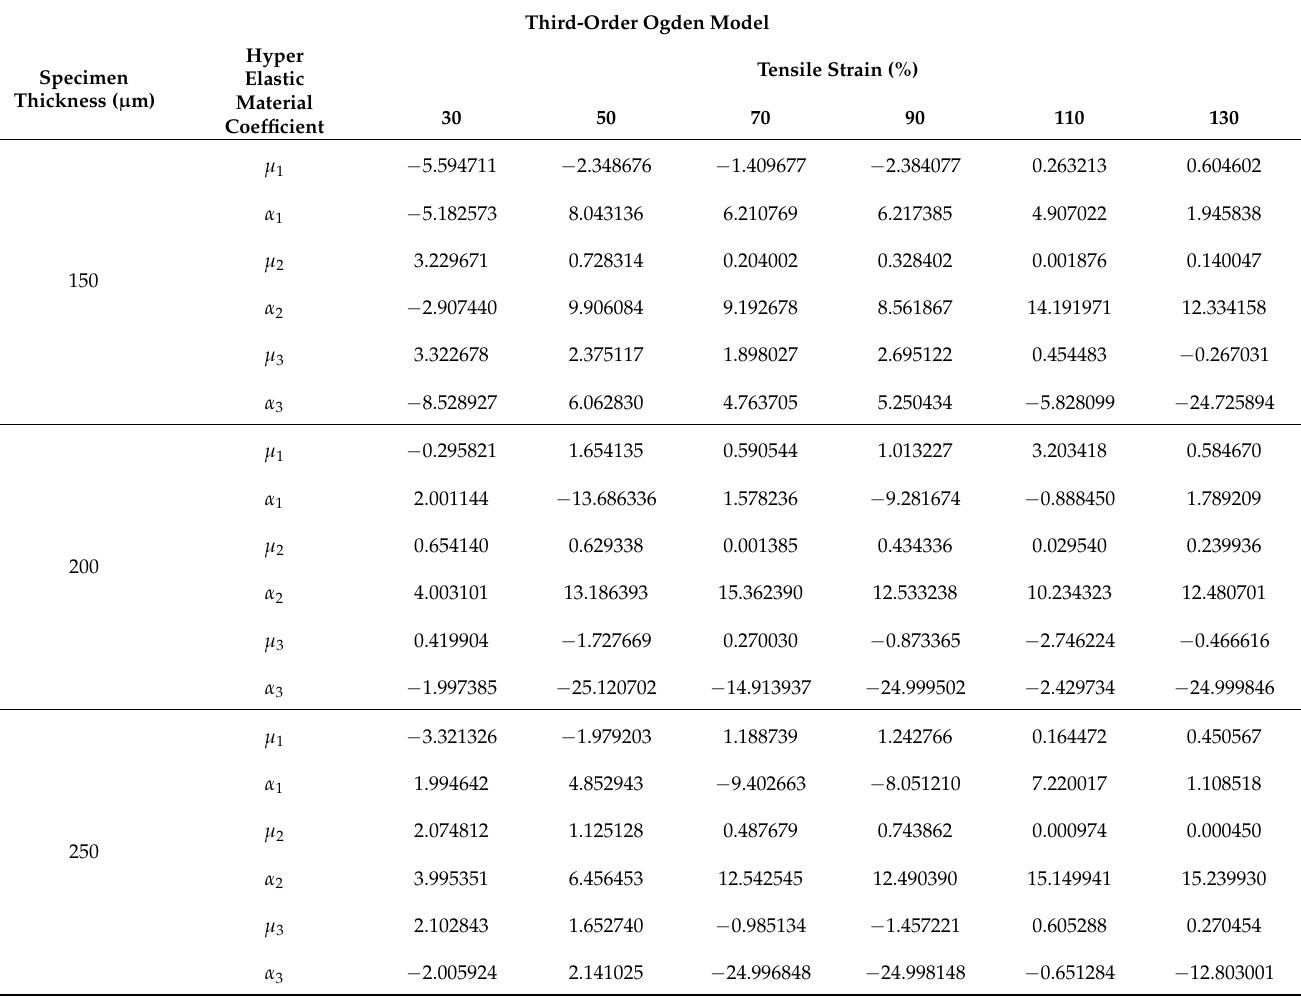
Table 4. Coefficient of the hyperelastic material models against tensile